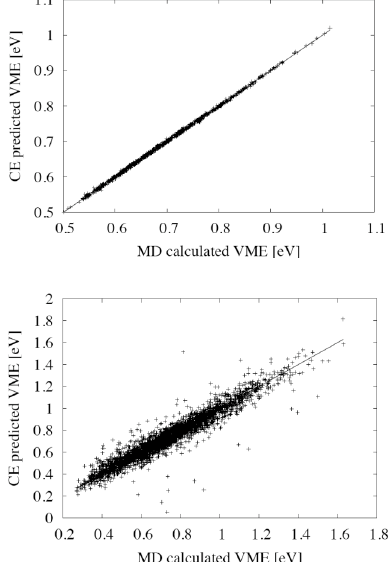
Fig. 7. Cluster expansion VME predictions for the FeCu1nn (up) and FeVac1nn problems (down), with pair and triplet interactions taken into consideration. The average errors are respectively 0.29% and